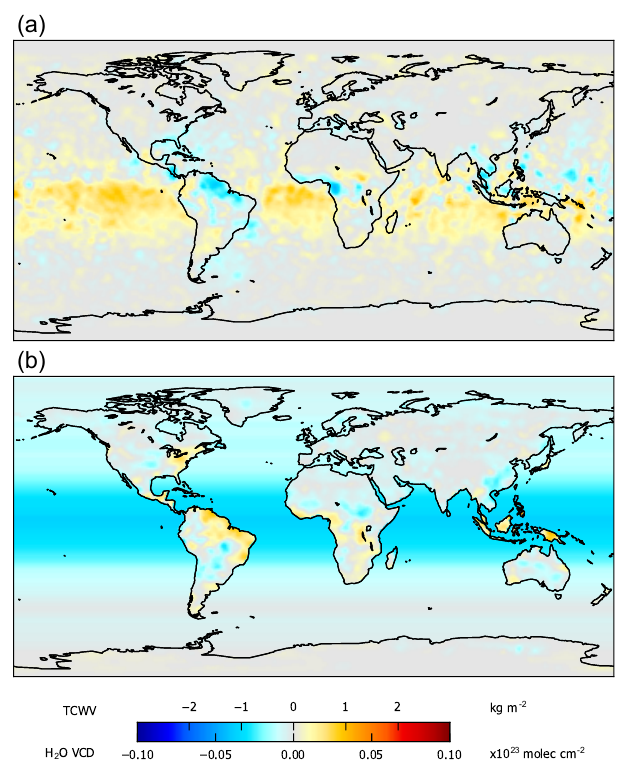
Figure 9. Final offset correction applied to GOME (a) and GOME- 2 (b) . See text for